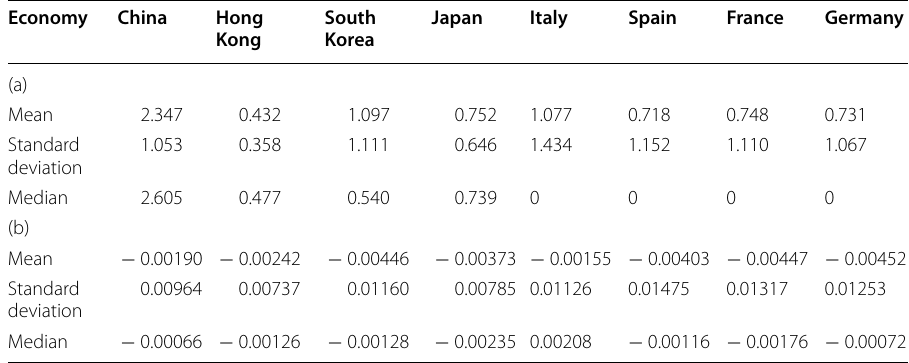
Table 1 Descriptive statistics of (a) ln